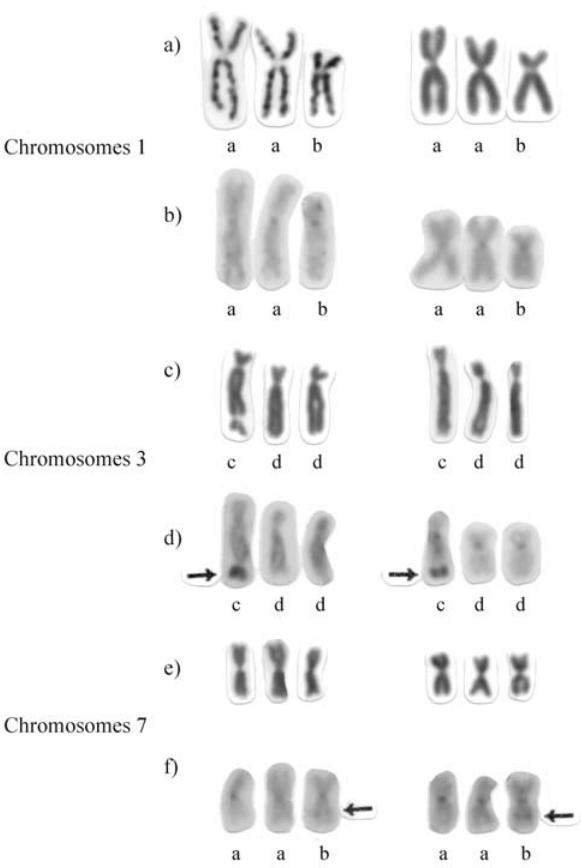
Figure 4 - Conventionally stained (a, c, e) and C-banded (b, d, f) hetero- morphic chromosomes 1, 3 and 7 from different triploid specimens of Dolichoplana carvalhoi . The arrows indicate the C-banding heteromor- phisms. The letters under the chromosomes represent their